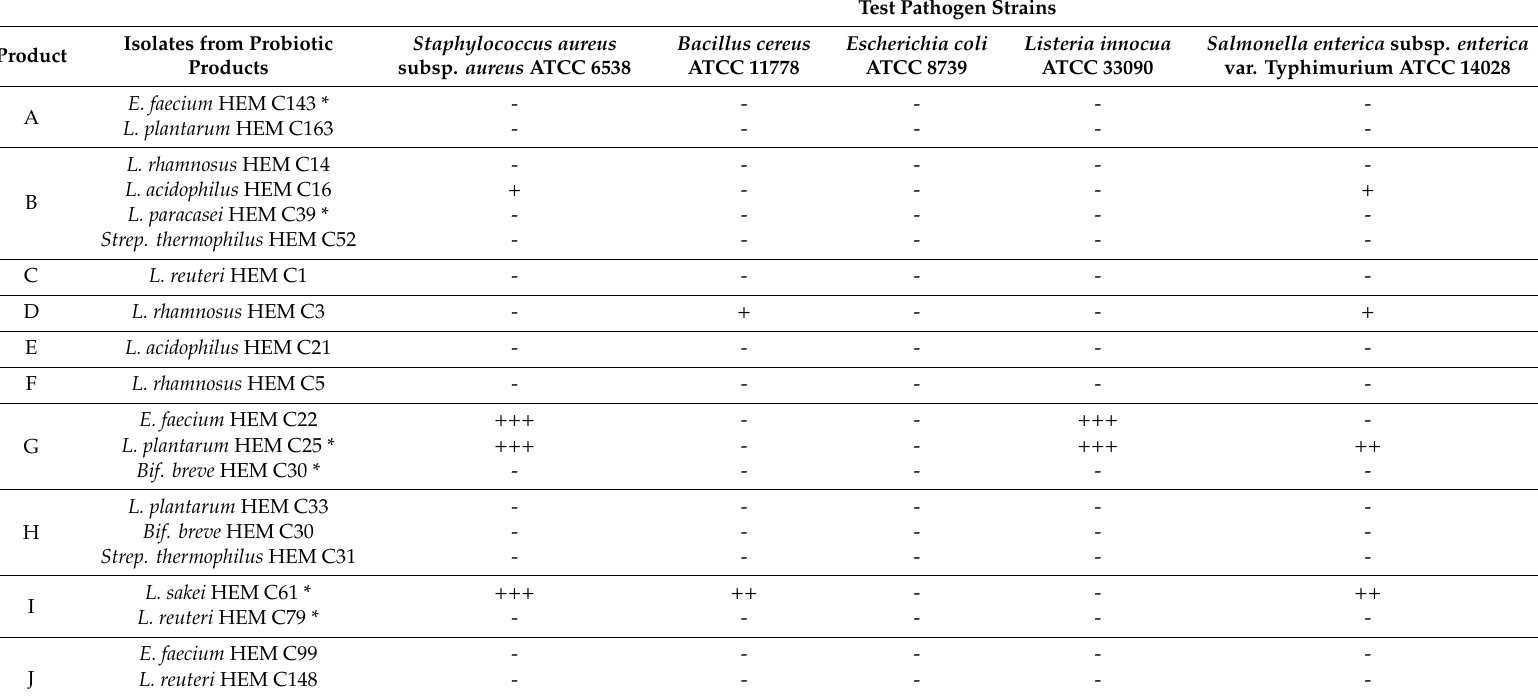
Table 5. Zones of inhibition against five di ff erent pathogens exhibited by isolates from commercial products. For strain numbers refer to Table